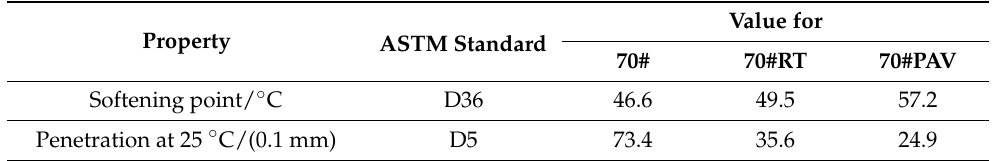
Table 1. Test results of matrix asphalt and aged asphalt.